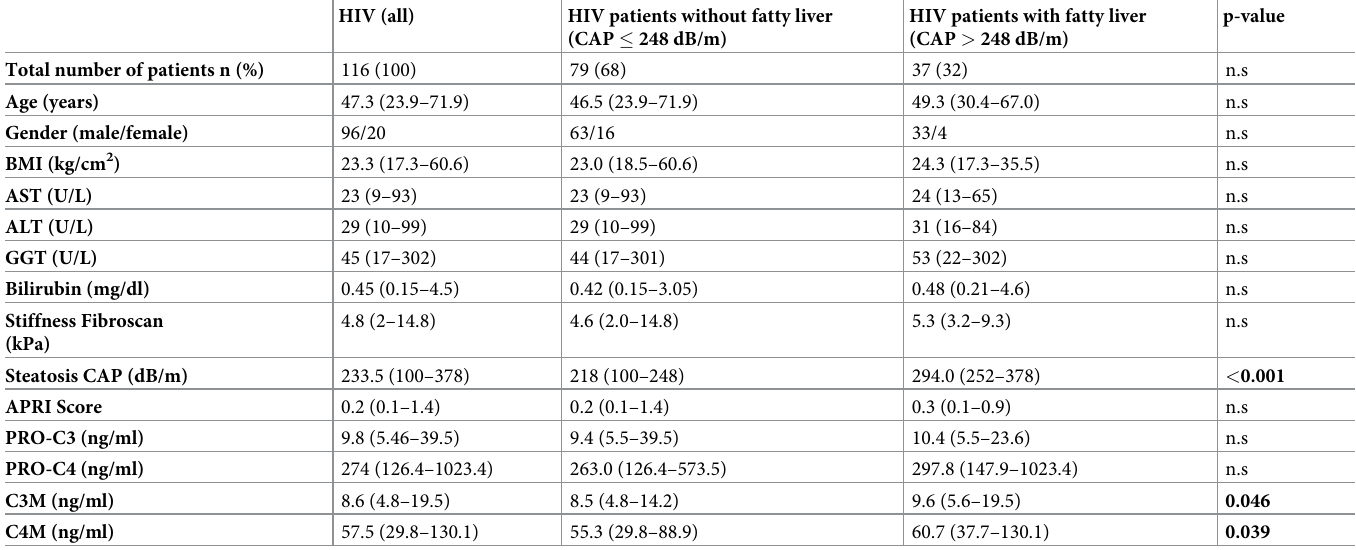
Table 2. Clinical parameters stratified by CAP values. All values are given as median and range. BMI: Body-mass index, AST: aspartate aminotransferase, ALT: alanine aminotransferase;; GGT: γ –glutamyl-transferase, CAP: Controlled attenuation parameter. HIV (all) HIV patients without fatty liver HIV patients with fatty liver (CAP � 248 dB/m) (CAP > 248